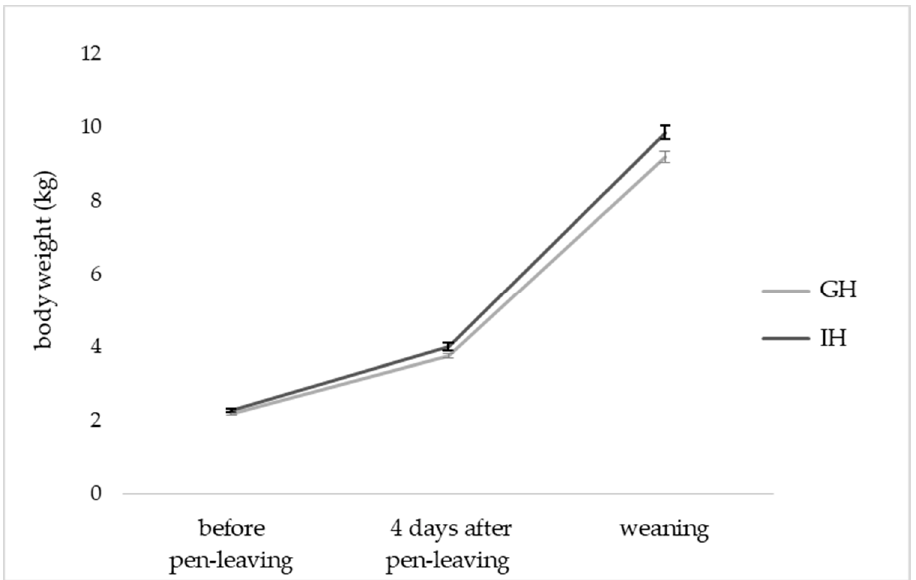
Figure 4. Least-Square-Means and standard errors (±SE) of the body weights (kg) during the suckling period (before pen-leaving = 1st week; 4 days after pen-leaving = 2nd/3rd week; weaning = 5th week of life) for GH (group housing n = 274 piglets) and IH (individual housing n = 126 piglets).